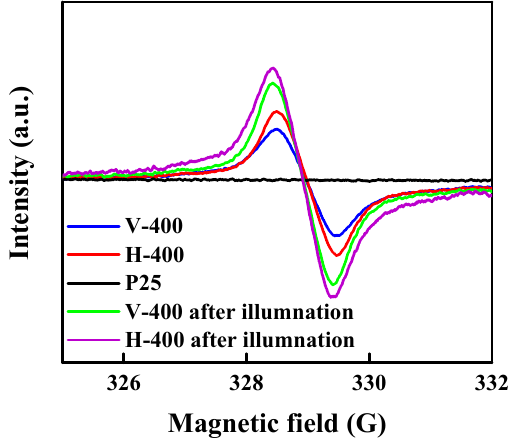
Figure 5. EPR spectra for P25, H-400, V-400 after and before illumination under 1.5 G solar light for 30 min.